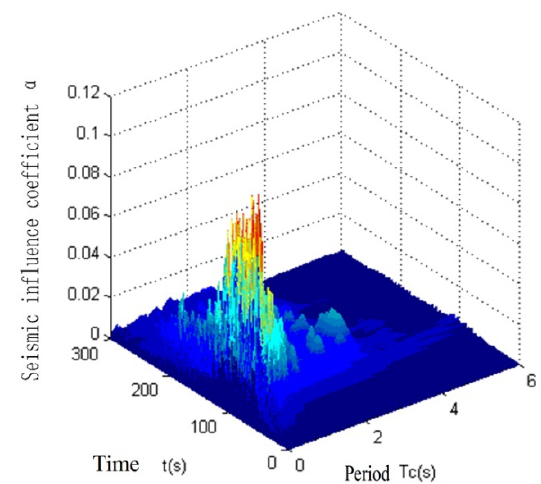
Figure 7. Time-domain curved surface of the seismic influence coefficient of absolute acceleration (time interval of 0.01 s).